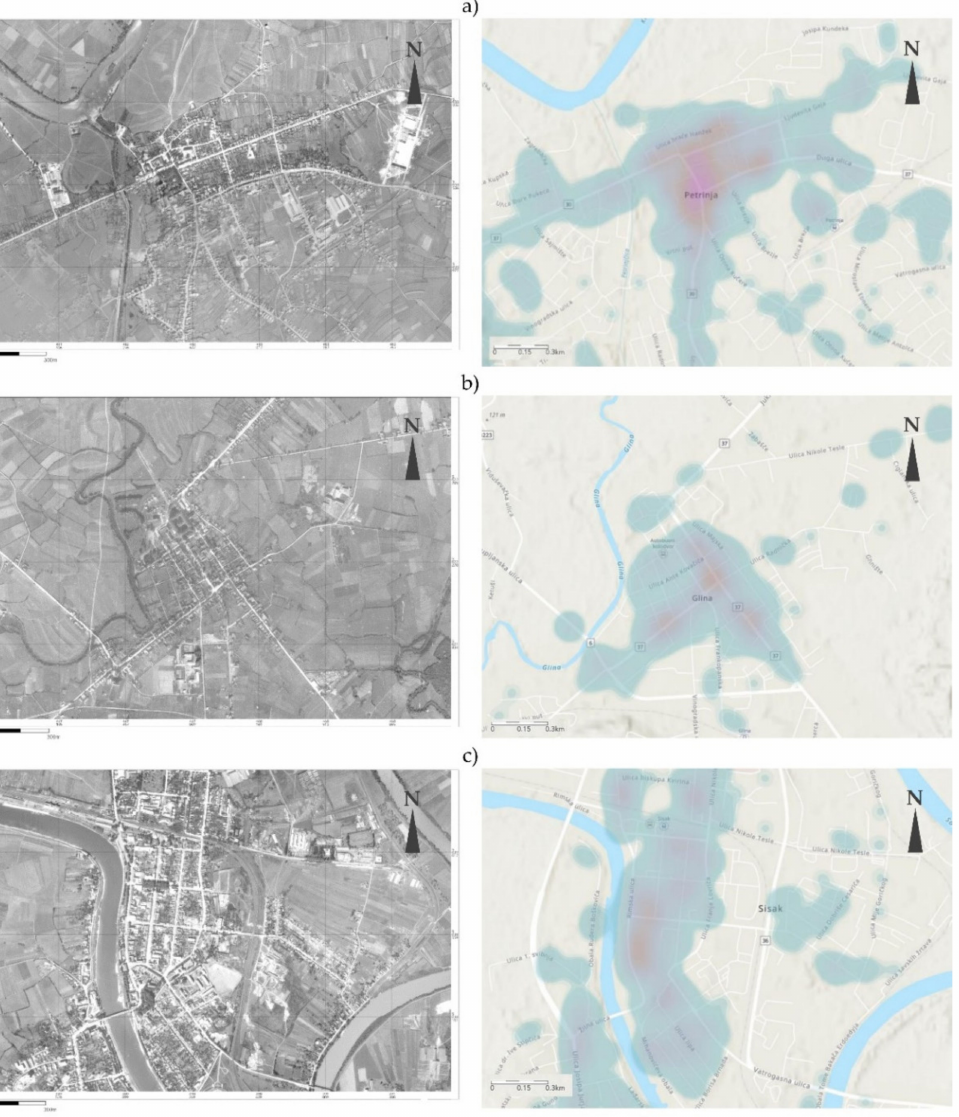
Figure 10. Digital orthophoto map from 1968 [49] (left) and the very heavily damaged, namely, Grade 4 (DG 4) or building collapse, namely Grade 5 (DG 5) distribution [50]—a qualitative display (right): ( a ) city of Petrinja; ( b ) town of Glina and ( c ) city of Sisak in Sisak-Moslavina County (scale